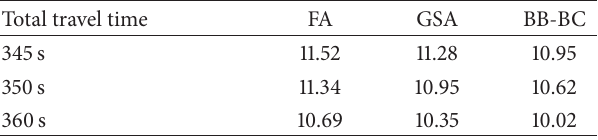
Table 6: Energy consumption (kwh) for different time limits (with passenger).